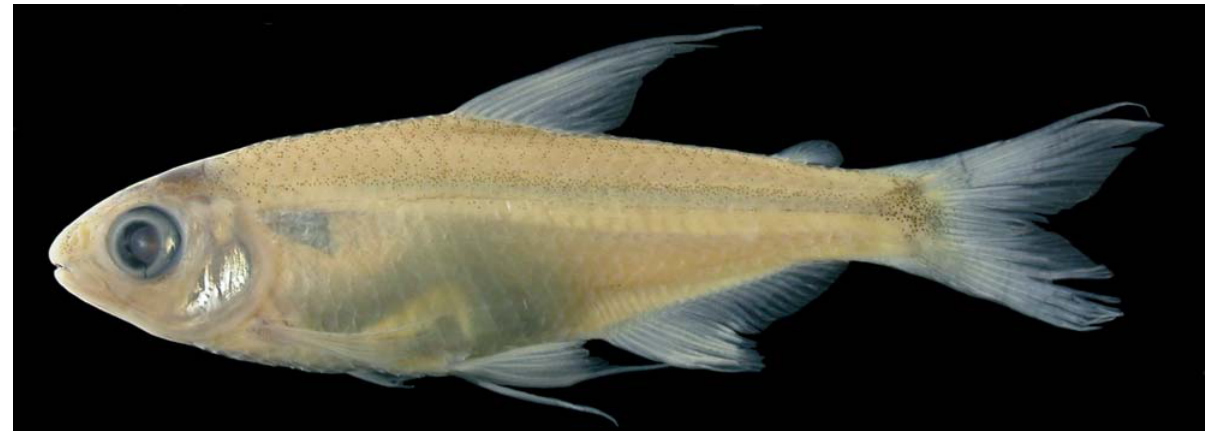
Fig. 23. Holotype of Odontostilbe pao , MCNG 54497, male 29.3 mm SL.